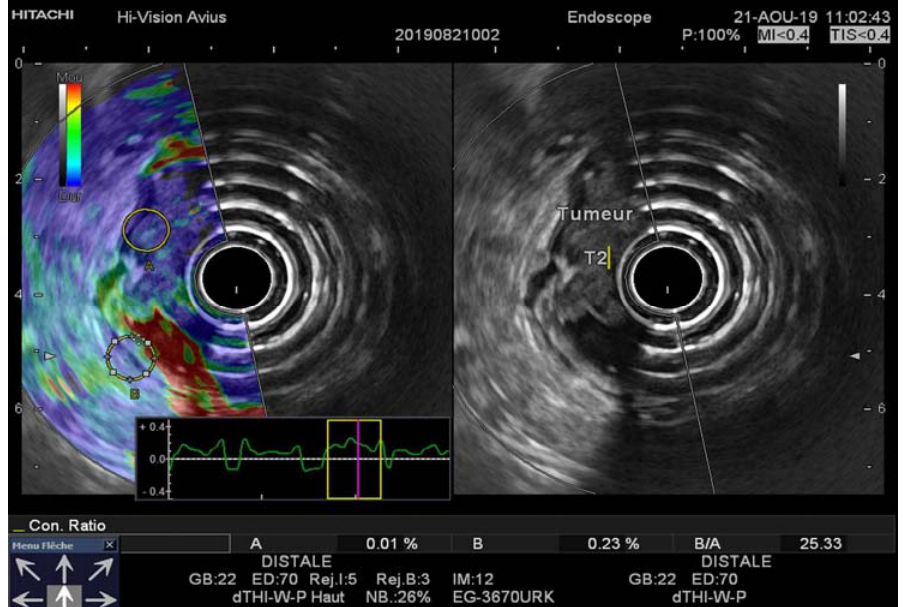
Figure 2. ( A ) EUS-RTE aspect in a 59-year-old male with pT2 rectal cancer. The tumor was classified as T2 by using the strain ratio (B/A); ( B ) EUS aspect of the same tumor confirmed by histopathologic examination after surgical resection. RTE, real-time elastography; EUS, flexible endorectal ultrasound.